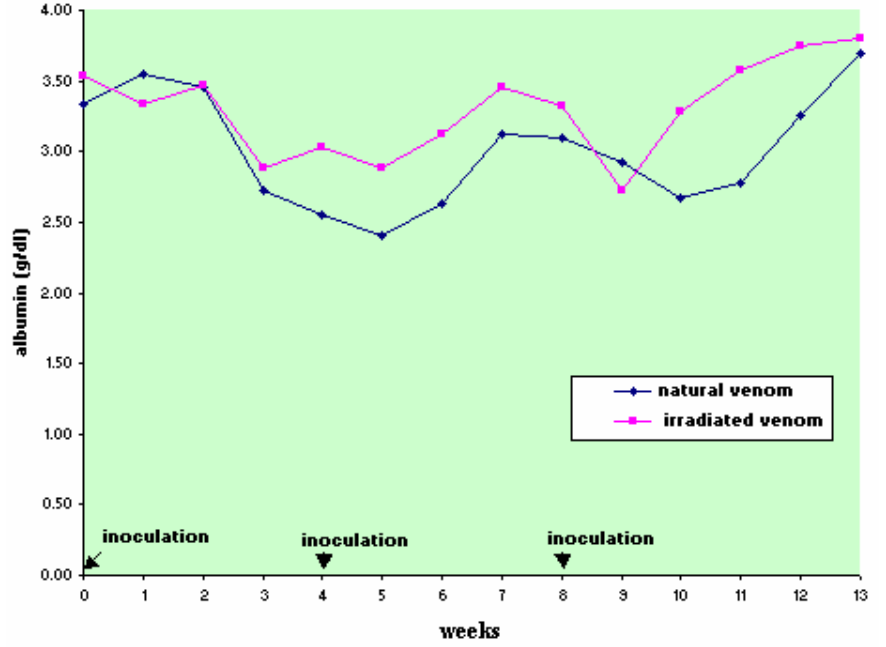
Figure 7. Mean values of albumin levels (g/dL) in sheep (n=12) inoculated with natural (NV) -irradiated (IrV) crotalic Cobalt 60